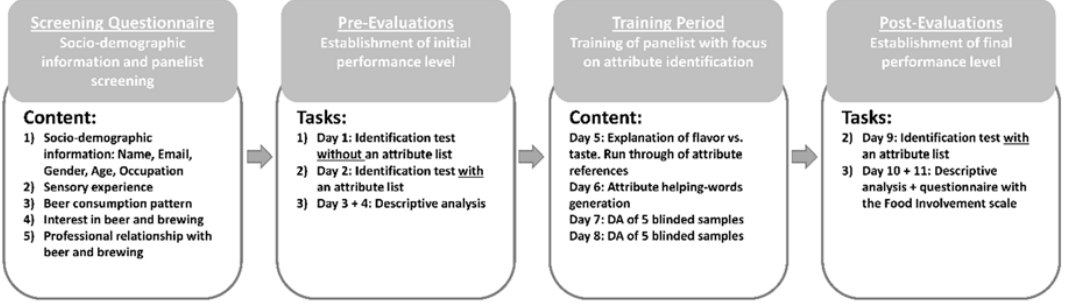
Figure 1. Overview of the experimental parts: Screening questionnaire, pre-evaluations, training period, and post-evaluations. The content / tasks during each step is described in the boxes.